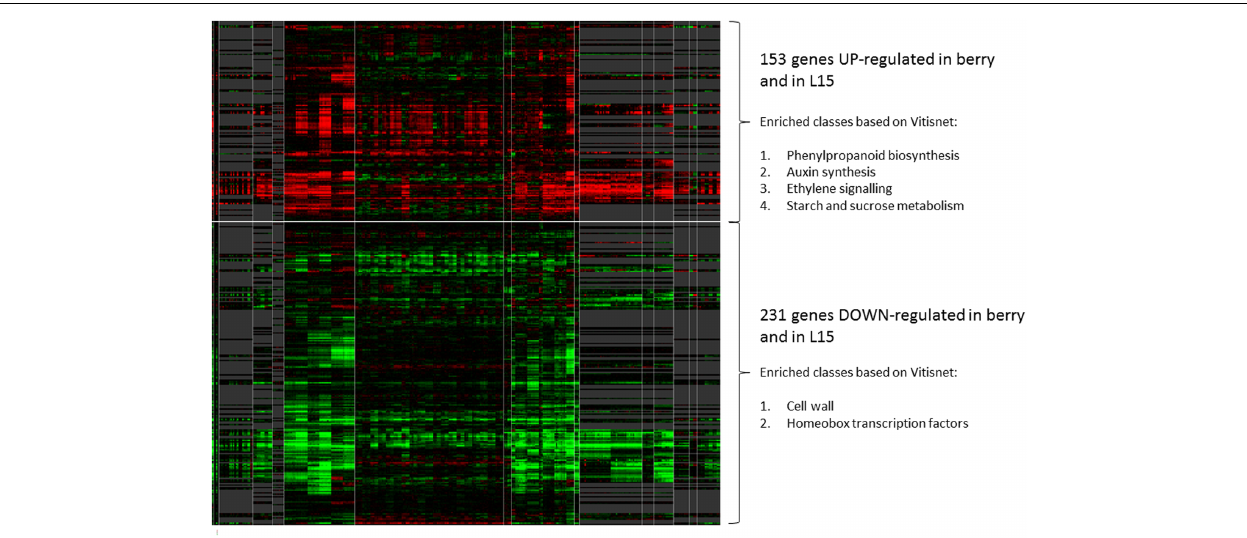
FIGURE 8 | Expression analysis of DEGs during berry ripening. Heatmap showing L15-DE genes modulated during berry ripening in 389 condition contrasts derived from 16 experiments relative to berry samples at different developmental stages, between EL 27 and EL 41. The heatmap was produced using the grapevine gene expression compendium VESPUCCI (http://vespucci.colombos.fmach.it/). Genes up-regulated or down-regulated in ripe berry are grouped respectively in the upper or lower part of the heatmap. The white vertical lines delimit the different experiments to which the selected contrasts belong. On the right, some